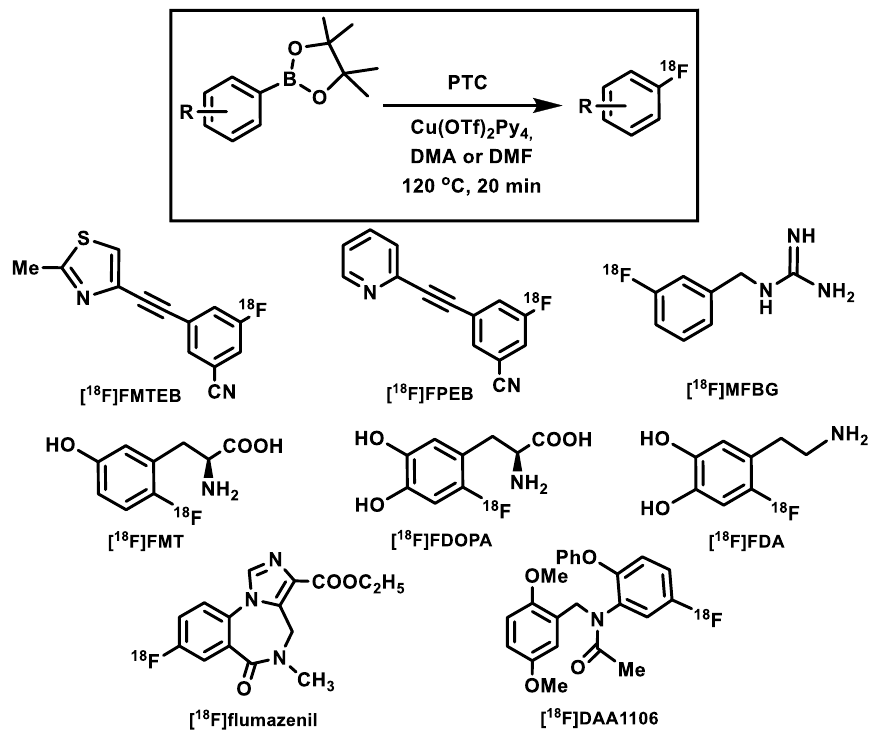
Figure 4. Synthesis of eight radiotracers via Cu-mediated 18 F-fluorination of arylBPin precursors using Cu(OTf) 2 (Py) 4 as a copper source [90].